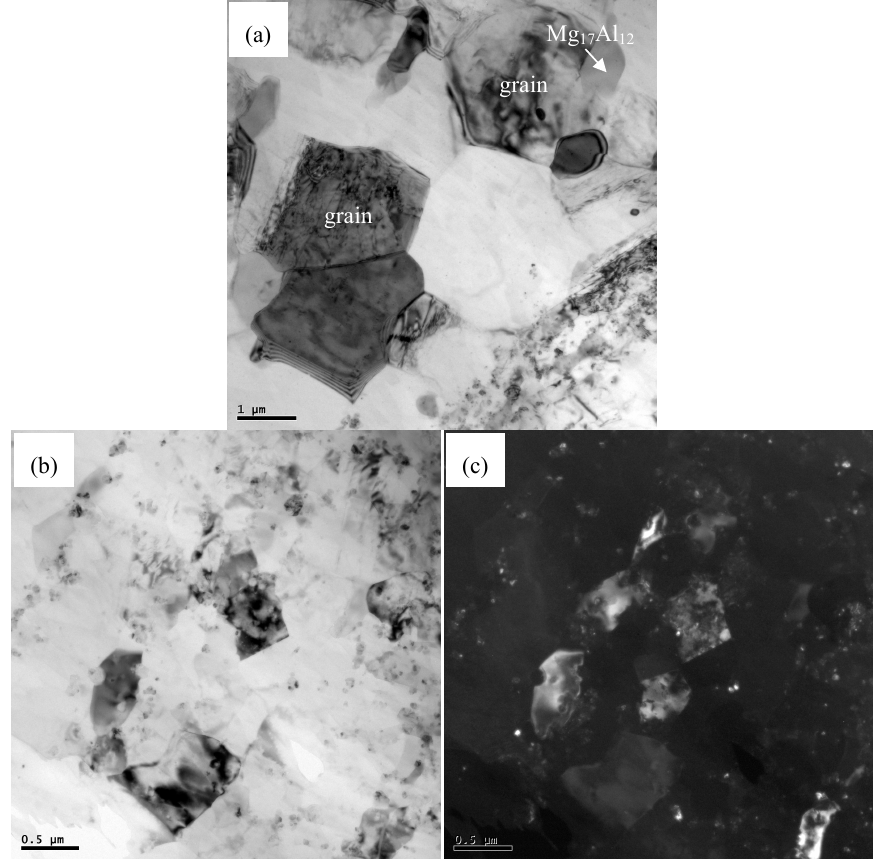
Figure 5. TEM micrographs of nano-SiCp/AZ91 composite after multi-pass forging for 12 passes (400-6P + 350-3P + 300-3P): ( a ) DRX grains and precipitated phase, ( b , c ) distribution of SiC